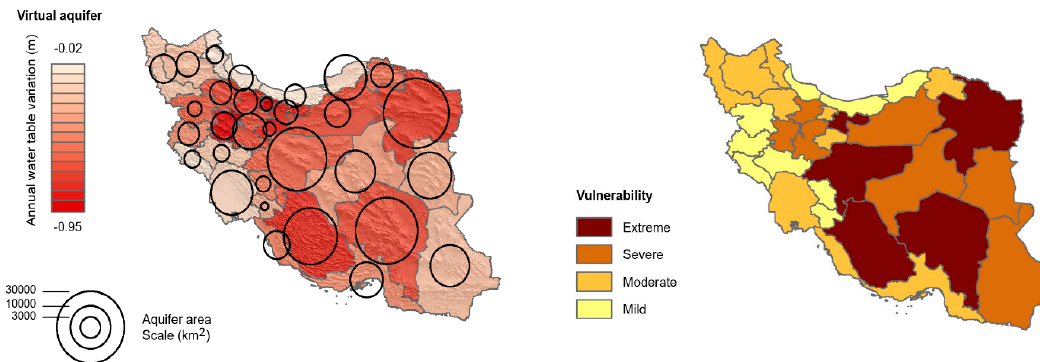
Figure 15. Representative (virtual) aquifer and groundwater vulnerability in each province (mild vulnerability: GVI = 0–0.21, moderate vulnerability: 0.21–0.83, severe vulnerability: 0.83–2.98, extreme vulnerability: GVI = 2.98–10 [39]).